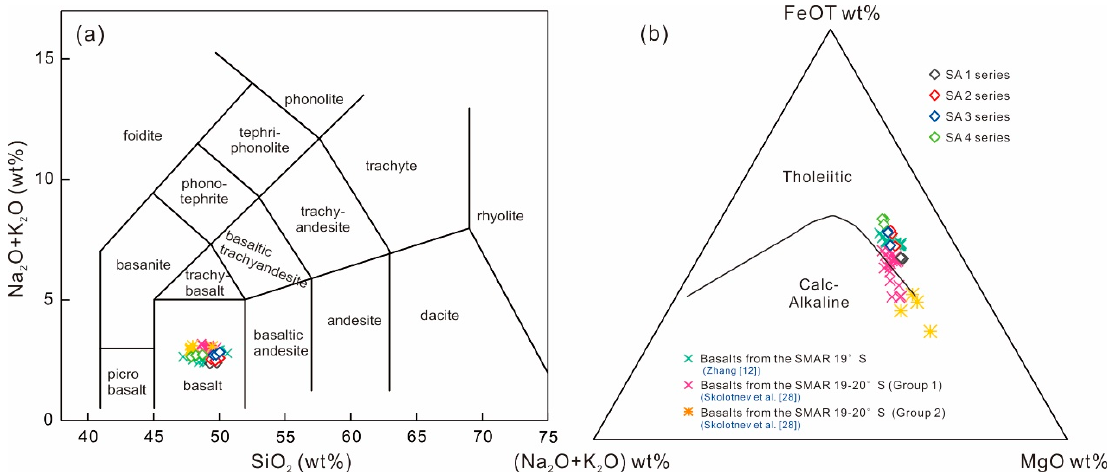
Figure 4. Diagrams of ( a ) SiO 2 versus (Na 2 O + K 2 O), as modeled after [54]; and ( b ) SiO 2 versus FeOT–(K 2 O + Na 2 O)–MgO, as modeled after [55], of the SMAR basalt samples. Data for basalts from the SMAR 19°–20°S are from [12,28].